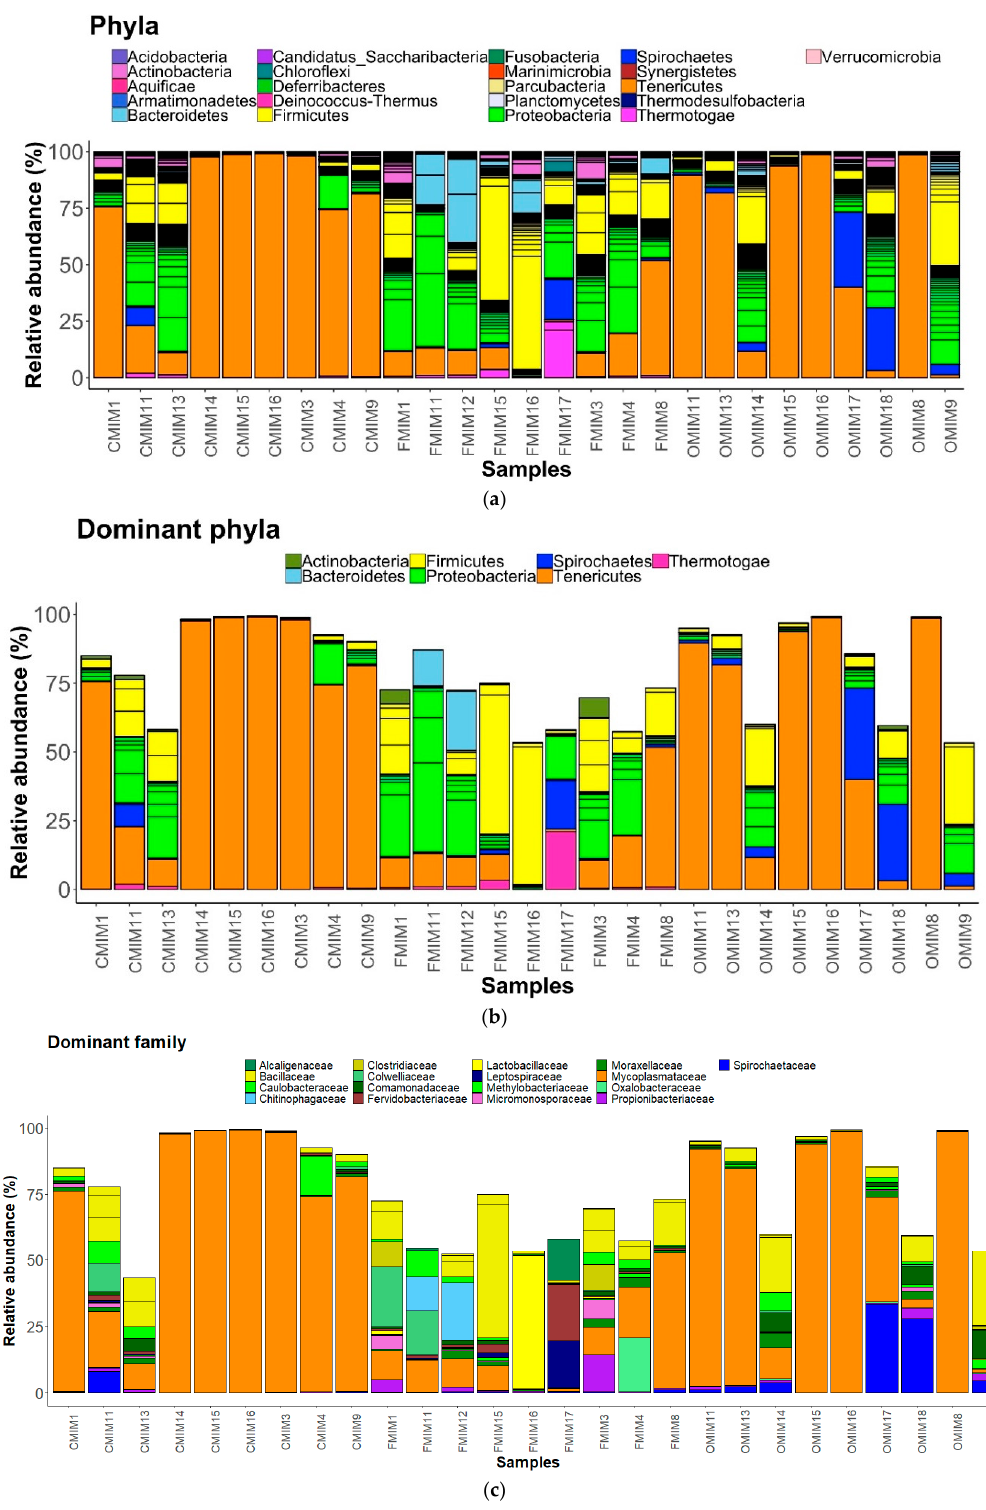
Figure 4. The relative abundance of the bacterial taxa present in the mid intestine mucus of Atlantic salmon. All the bacterial phyla ( a ), dominant phyla ( b ), and dominant families ( c ) in the mid intestine mucus of Atlantic salmon from the three fish groups. Color codes for Proteobacteria—Shades of green, Spirochaetes—Dark blue, Firmicutes—Yellow, Actinobacteria—Orchid, and Tenericutes—Dark orange. The samples with C prefixes come from the control group. Similarly, those with F and O show the florfenicol- and oxolinic-acid-fed groups,